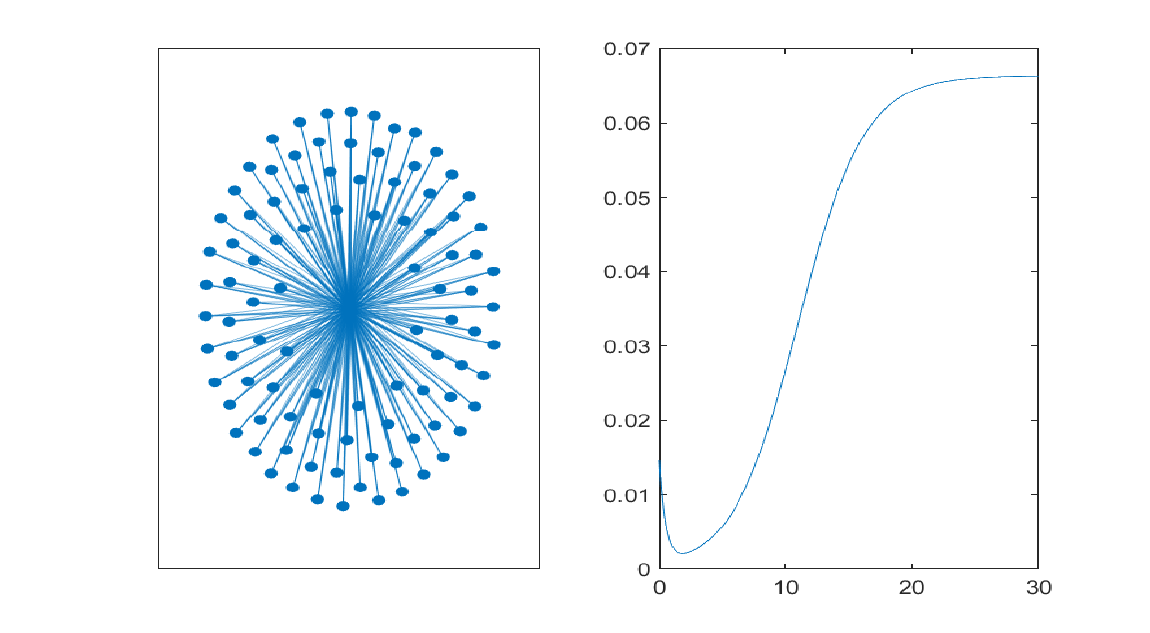
Figure 5. Core-periphery graph with five core nodes and 95 periphery nodes ( left ). Time evolution of the mean value of non-performing loans on the graph ( right ).